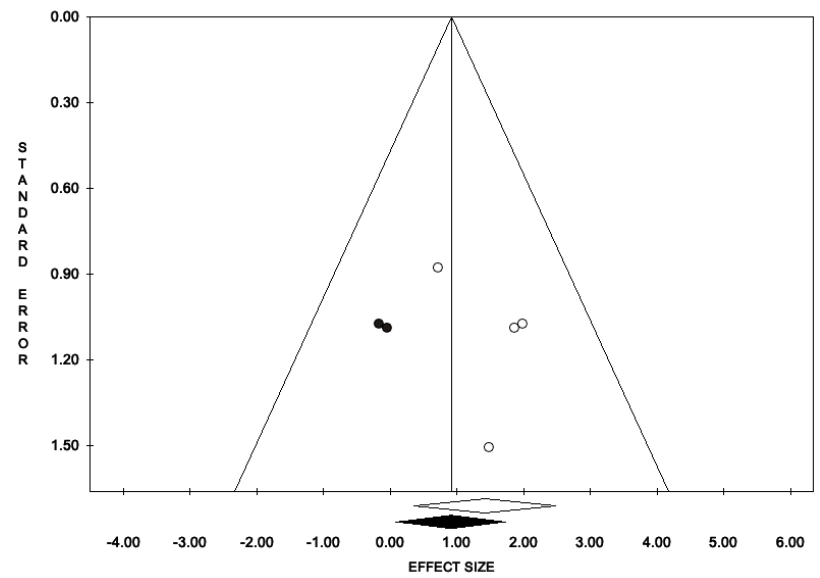
Figure 9. Funnel plots of the meta-analysis evaluating the OR for dyspepsia. Egger’s linear regression (t = 0.85, p = 0.486) and Begg and Mazumdar rank correlation test (z = 0.00, p = 1.00).